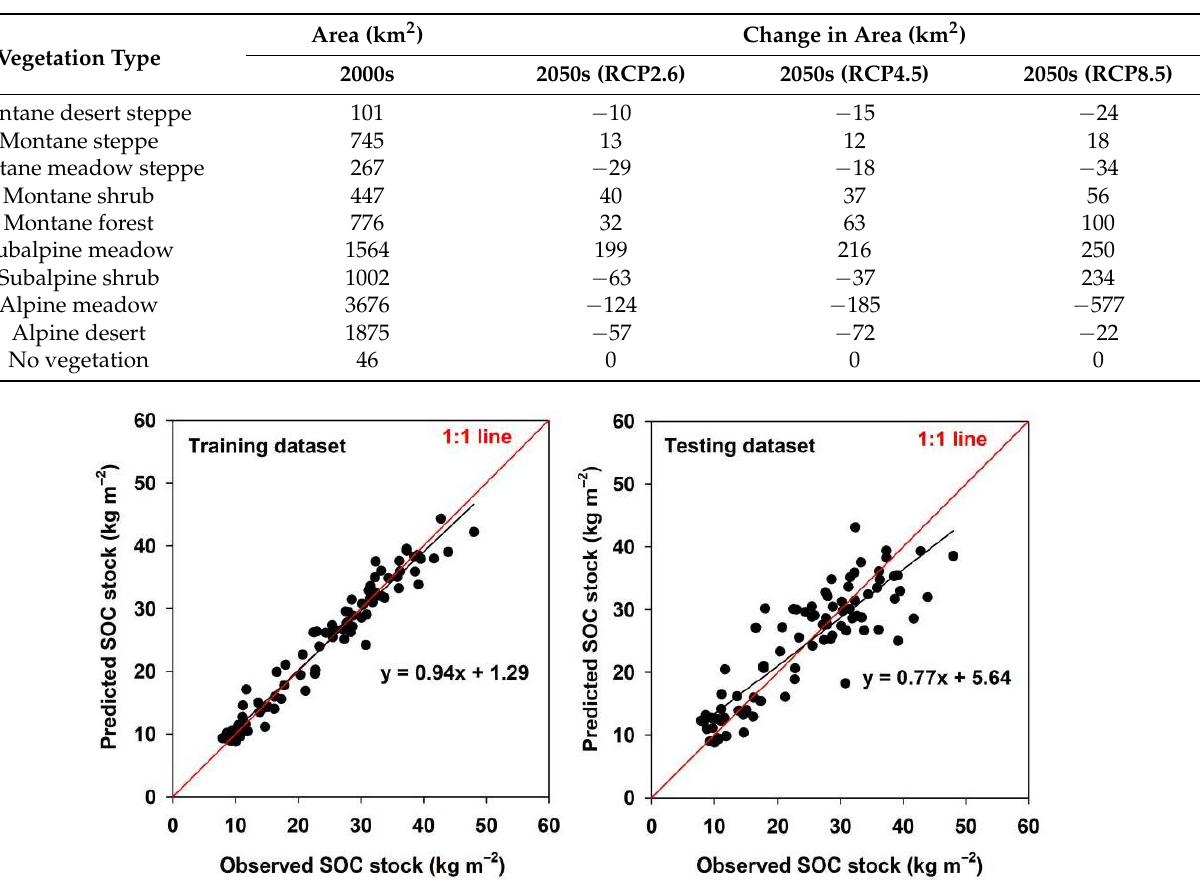
Figure 7. Distribution of NDVI for the 2000s and 2050s under the RCP2.6, RCP4.5 and RCP8.5 scenarios in the study area. Table 1. Change in the area of different vegetation types under different climate change scenarios.